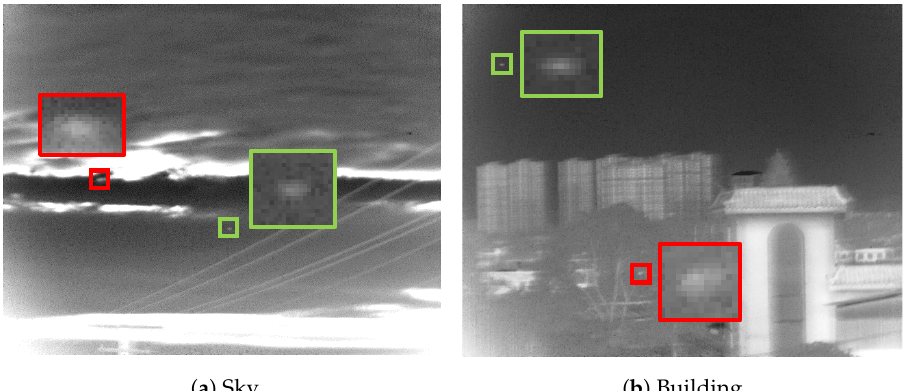
Figure 1. Infrared small targets in developed IRST640 dataset of sky ( a ) and building ( b ) scenes. The green and red box is the target and the false alarm,